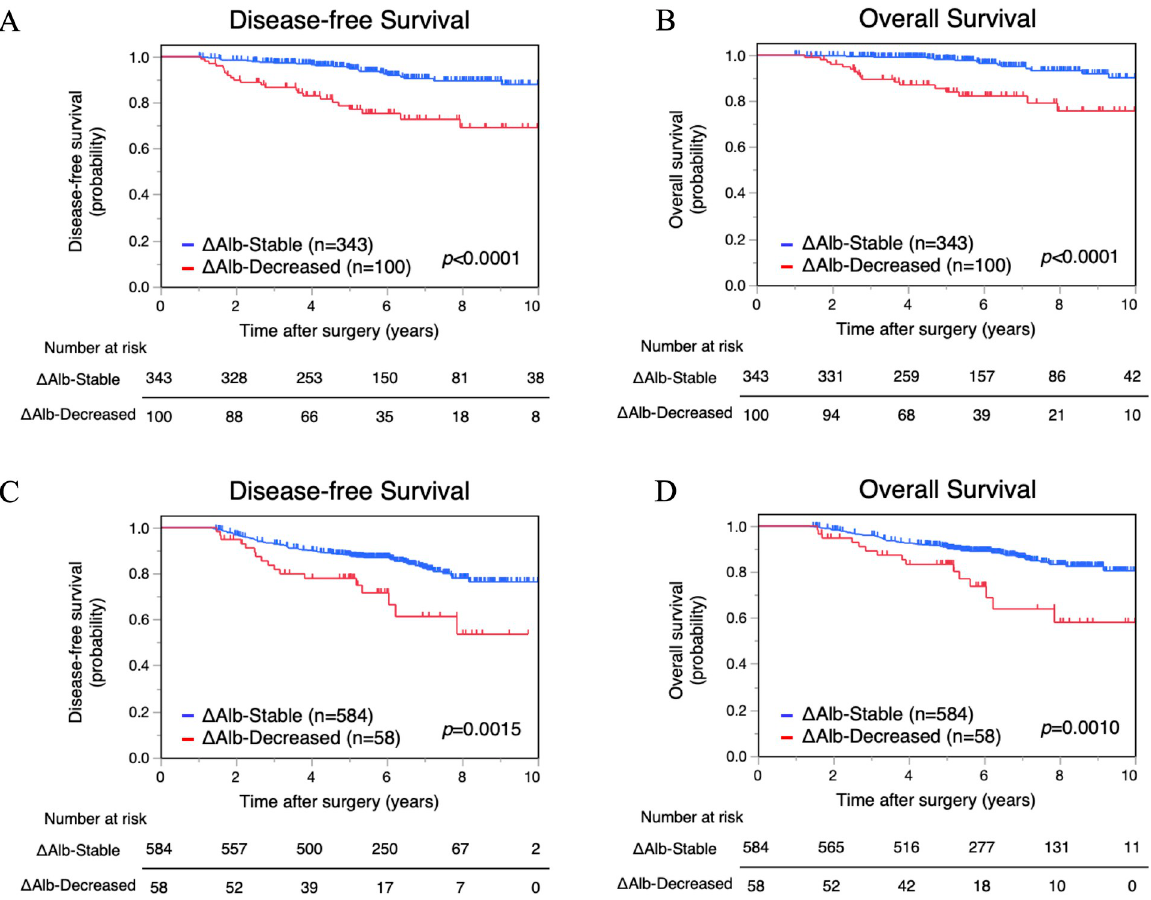
Fig 3. Survival analysis according to postoperative decrease in serum albumin ( Δ Alb). Disease-free survival and overall survival of the Δ Alb- Decreased and Δ Alb-Stable groups in the training cohort (A, B) and in the validation cohort (C,